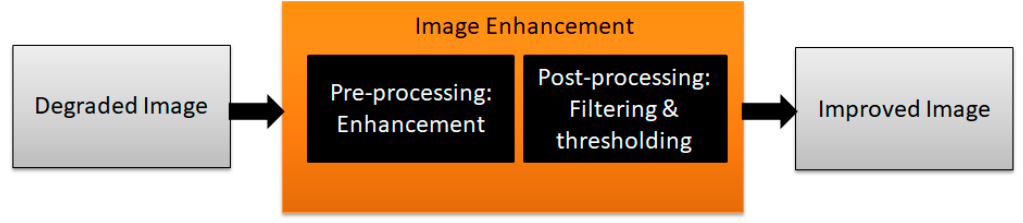
Figure 11. Typical architecture of degraded document binarization.